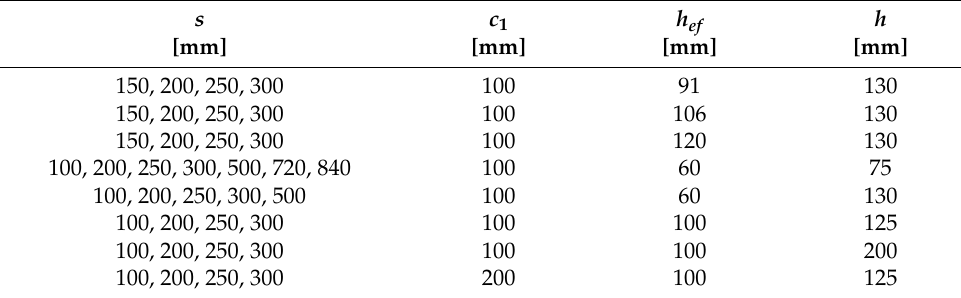
Table 7. Simulation program—influence of anchor